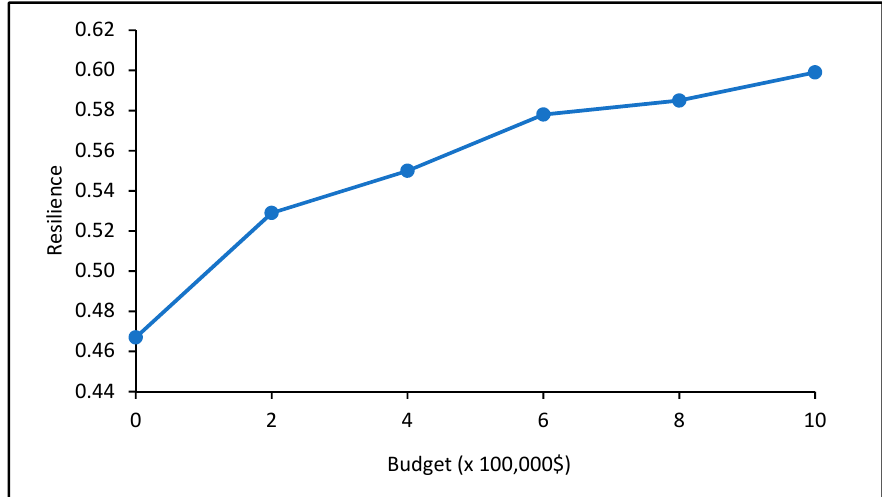
Figure 12. Resilience versus cost trade-off for LWDN.